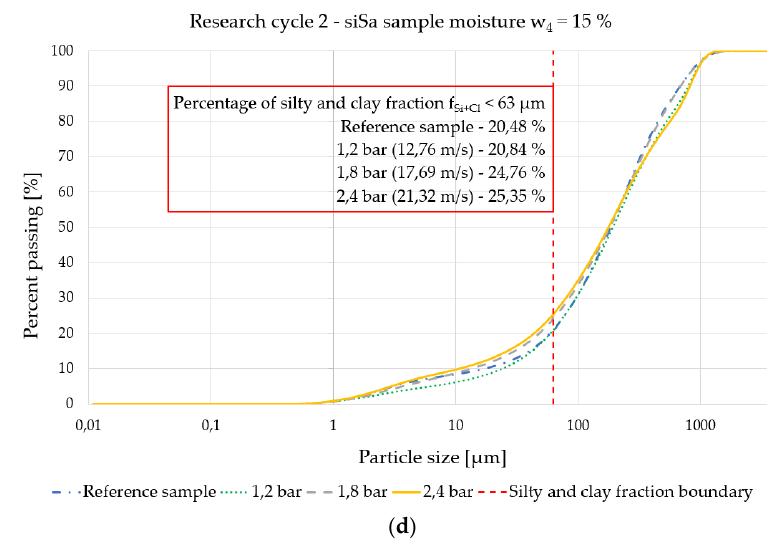
Figure 13. Summary graphs of grain size curves for silty sand with silt and clay fraction f Si+Cl ,2 = 20.48% for sample variants I–XIII (12 sample variants subjected to dynamic impact in SHPB and reference sample without dynamic impact) in variable configurations: ( a ) w 1 and p 1 ( v 1 )– p 2 ( v 2 )– p 3 ( v 3 ), ( b ) w 2